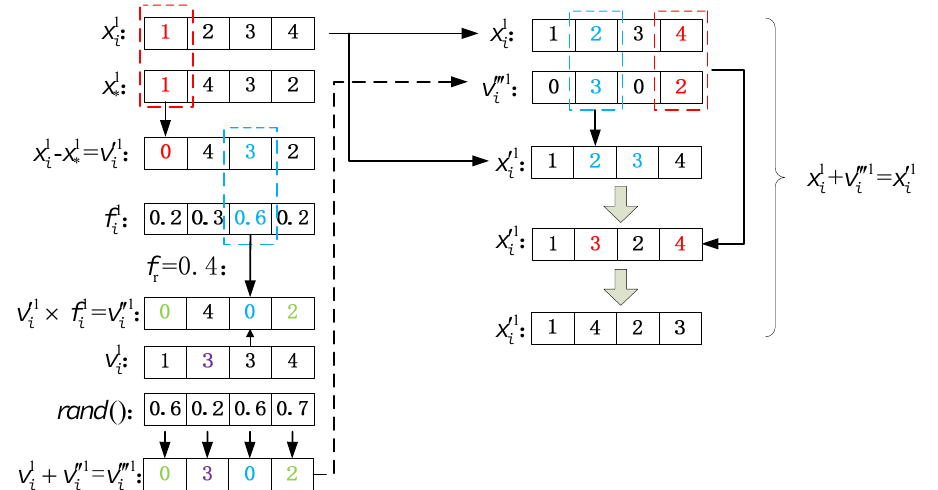
Figure 3. An instance for the update operations of bat position, velocity, and